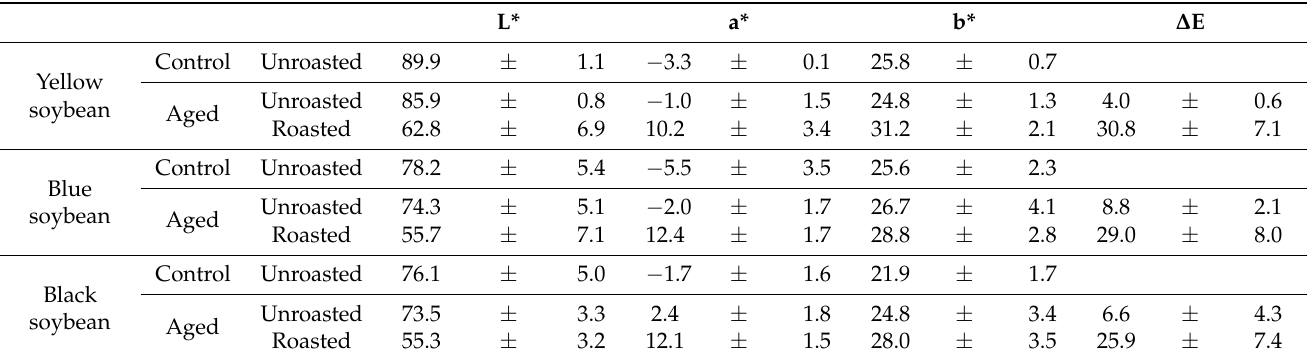
Table 4. Changes in color values of soybeans by storage and